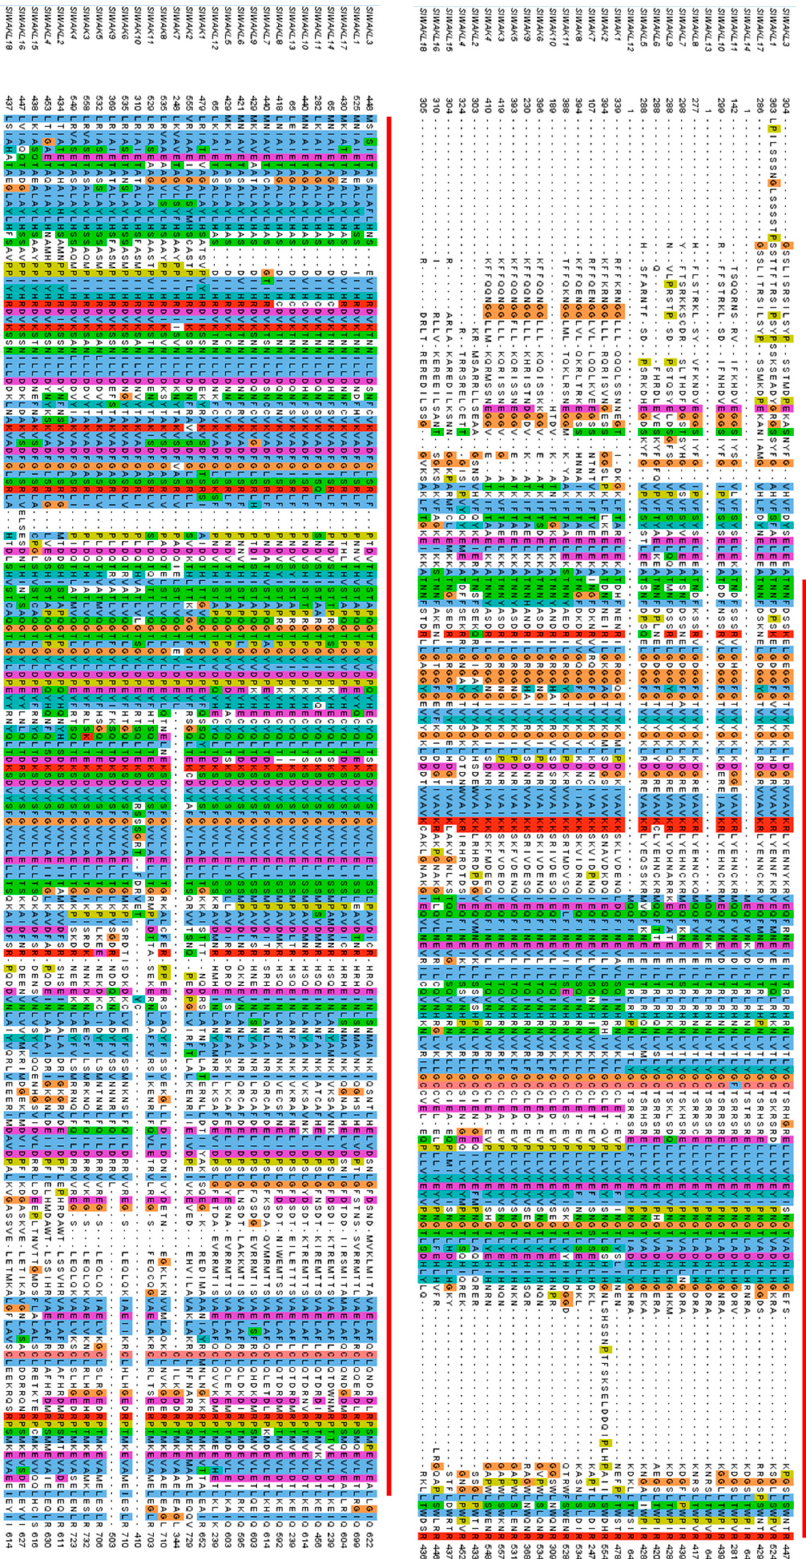
Figure 2. Sequence alignment of all identified SlWAK-RLK proteins. The SlWAK-RLKs family signature Pkinase in tomato is underlined. The conserved residues are indicated by a colorful background.